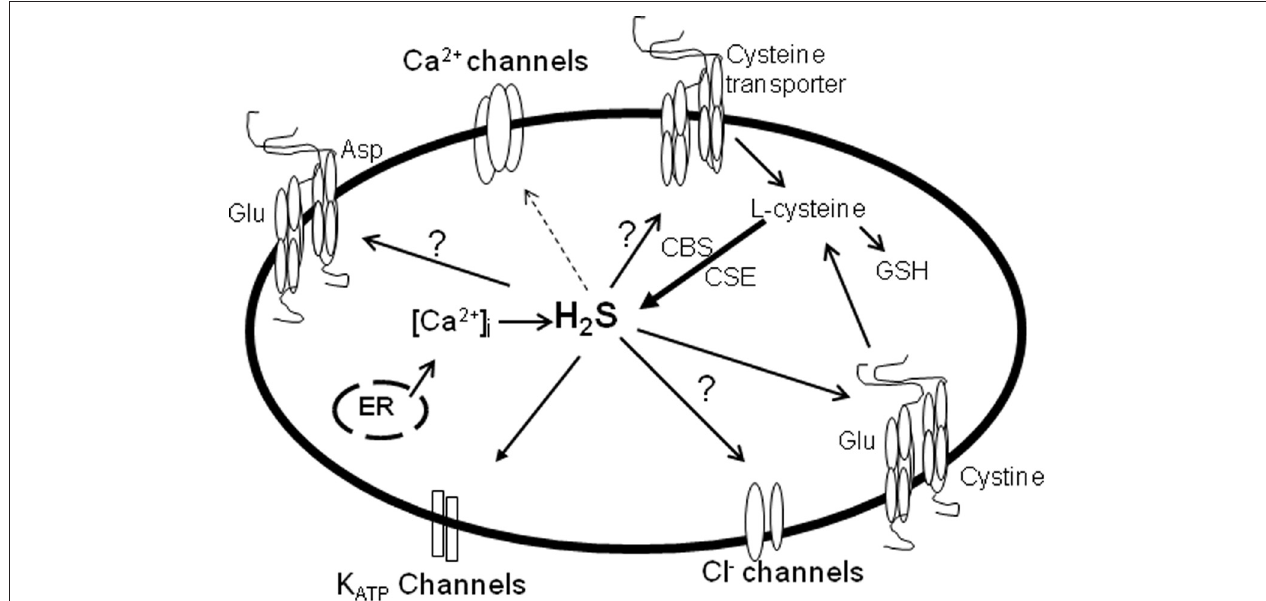
FIGURE 2 | The effects of H 2 S on ion channels and transporters in the eye. Solid arrow, stimulatory; dotted arrow, inhibitory. Studies on the effects of ion channels and transporters in the eye and/or their interaction with H 2 S is lacking. H 2 S which is formed by CBS and CSE activities, stimulates K ATP channels and the cystine/glutamate antiporter thereby regulating ocular